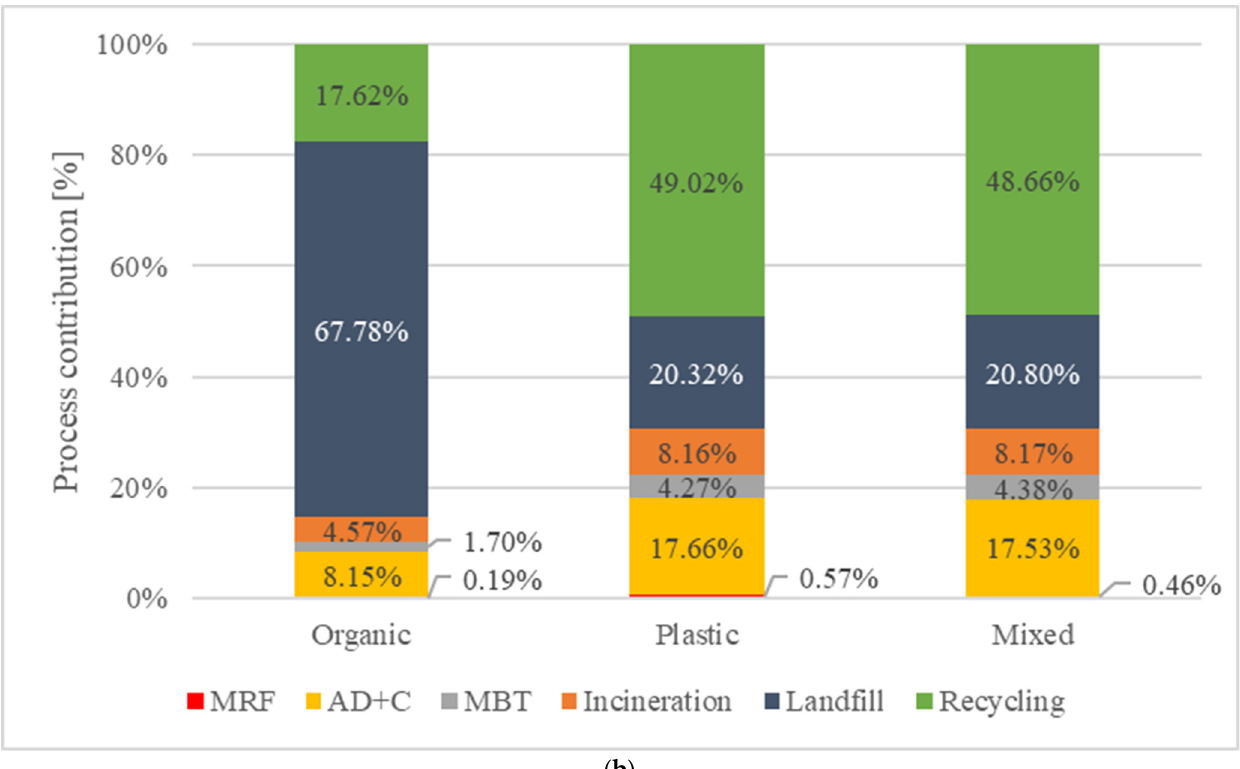
Figure 4. Carbon footprint results ( a ) and process contribution in the CF value ( b ) of organic, plastic and mixed waste treatment routes.